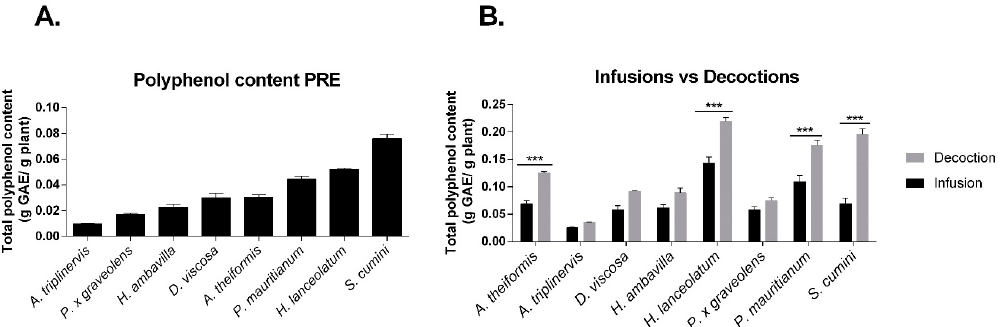
Figure 1. Total polyphenol content of the 8 medicinal plants depending on the preparation mode. ( A ) Medicinal plant polyphenol-rich extracts (PRE); ( B ) Infusions and decoctions. Polyphenol content was determined by Folin–Ciocalteu colorimetric assay and expressed as g gallic acid equivalent (GAE) / g plant. Infusions and decoctions were obtained with a ratio of 1 g plant / L of water, therefore g GAE / g plant = g GAE / L. Data shown are means ± SEM of three independent experiments. *** p < 0.005 as compared to decoctions.